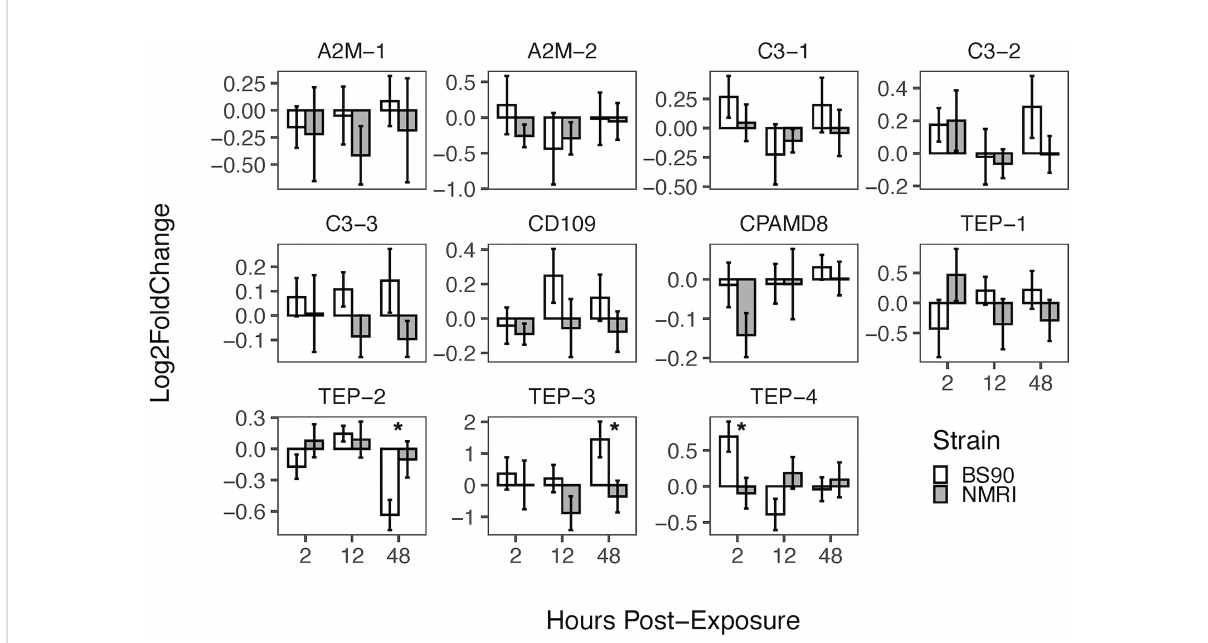
FIGURE 5 Expression of TEPs in B. glabrata snails exposed to S. mansoni miracidia. The expression of TEP transcripts was measured via qRT-PCR in resistant (BS90, white bars) and susceptible (NMRI, gray bars) at 2, 12 and 48 h after infection with 15 S. mansoni miracidia. To compare TEPs gene expression between BS90 and NMRI snail strains post-exposure, log-transformed expression levels of exposed snails were calculated relative to control snails for each strain using the Pfaf fl comparative method (n=9). Statistical analysis was performed using the non-parametric Mann-Whitney test due to non-normal distribution of the data. Values were considered signi fi cant if p ≤